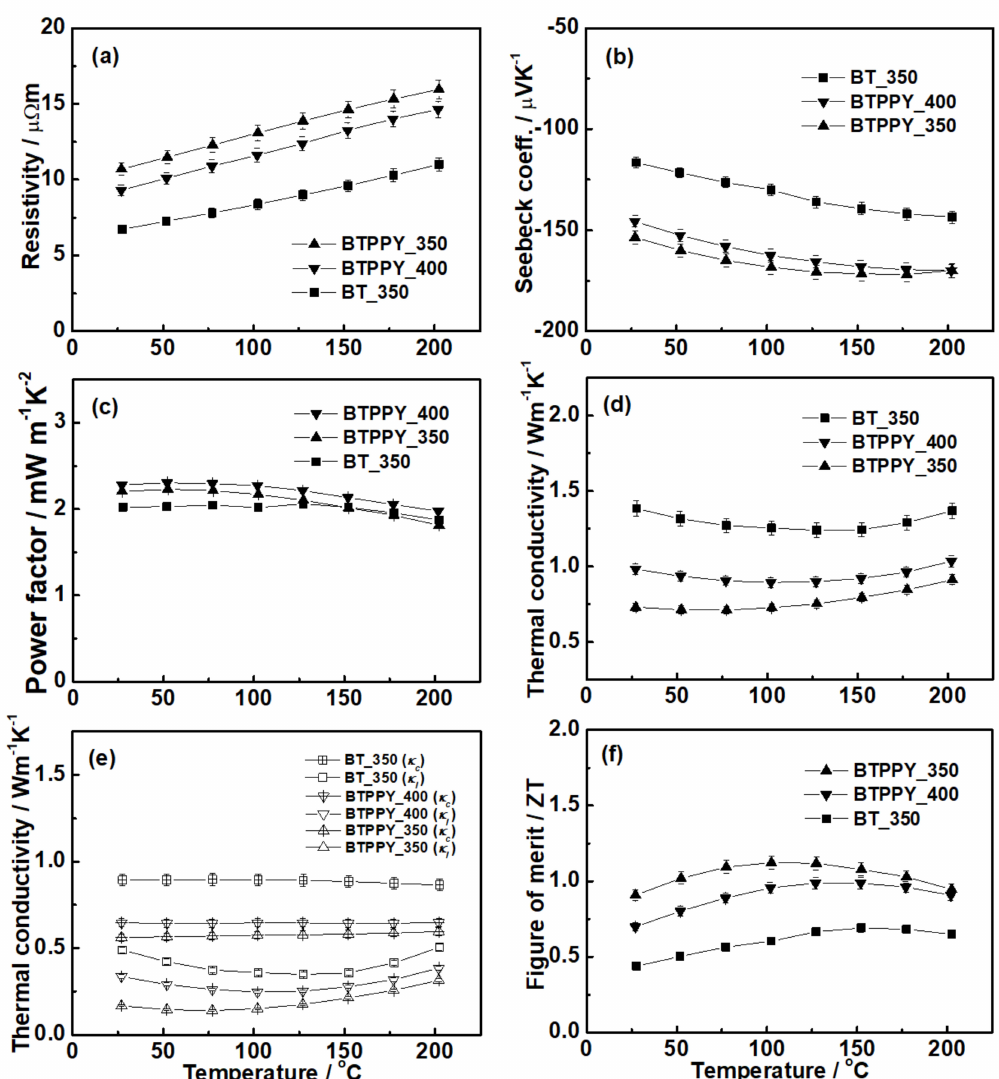
Figure 6. Thermoelectric properties of the pristine Bi 2 Te 3 and Bi 2 Te 3 –polypyrrole specimens sintered at 350 and 400 ◦ C: ( a ) electrical resistivity, ( b ) Seebeck coefficient, ( c ) power factor, ( d ) thermal conductivity divided into ( e ) carrier ( κ c ) and lattice ( κ l ) contributions, and ( f ) ZT. Error bars are shown when they exceed the symbol